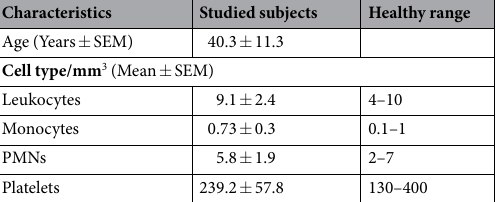
Table 1. Clinical and analytical characteristics of individuals included in the study. Data represents the Mean ± SEM of years (Age) or cell concentrations as cells/mm 3 (Blood cell types). Normal ranges of blood cell types’ concentrations in healthy conditions are also shown as a